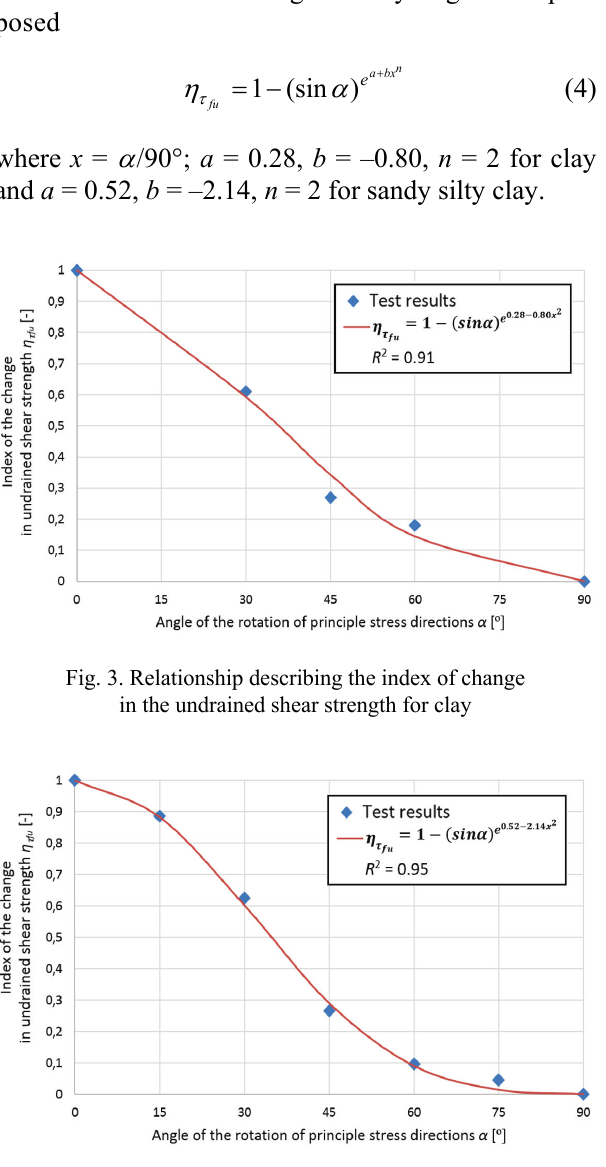
Fig. 4. Relationship describing the index of change in the undrained shear strength for sandy silty